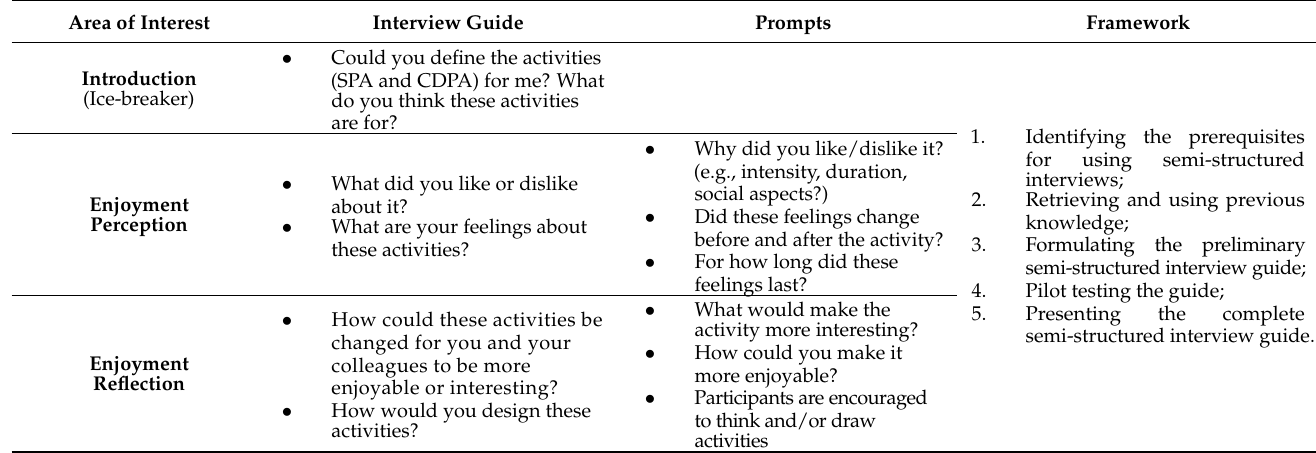
Table 1. Interview guide, prompts and framework by Kallio et al.